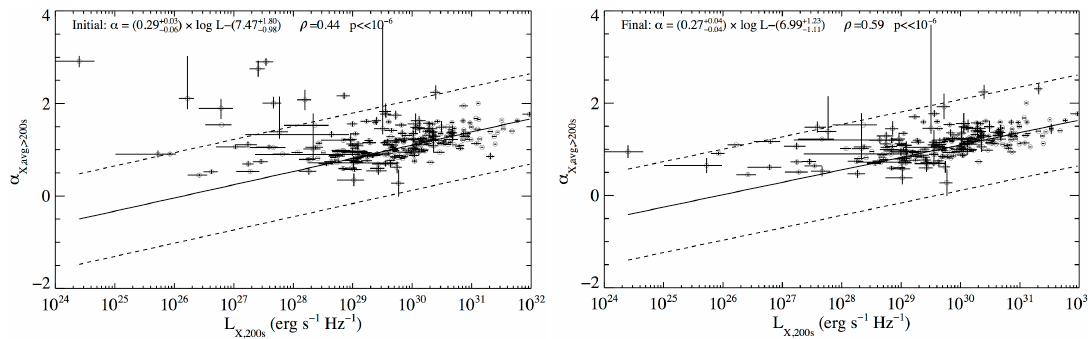
Figure 1. (Left) using the full sample of X-ray light curves with no optimization, corrections or filtering; (Right) final: using the sample of X-ray light curves that includes steep decay and flare corrections and only long duration GRBs . The best fit regression parameters and their 1 σ errors, and the Spearman rank coefficient, ρ , and associated probability, p , are given in each panel. The solid line indicates the best fit regression, and dashed lines indicate the 2 σ deviation (Reproduction of Figures 1 and 7 from